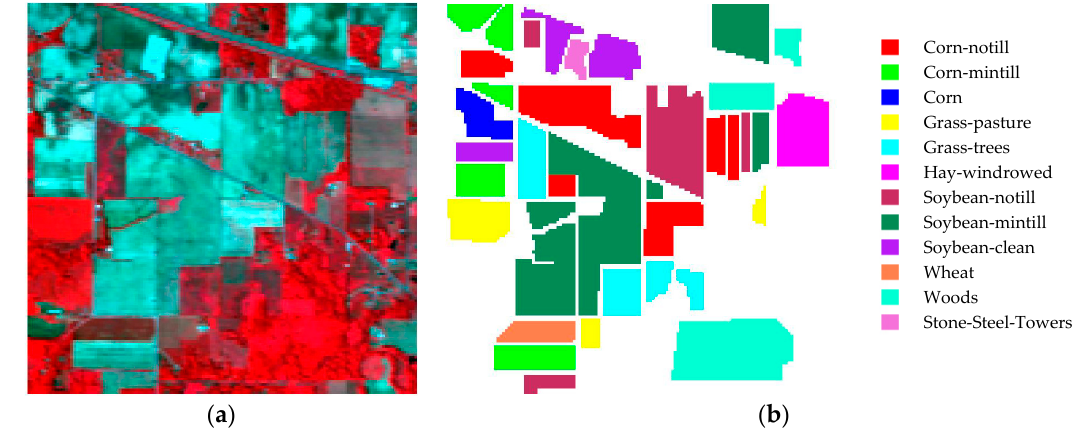
Figure 11. Indiana Indian Pines dataset: ( a ) False color composite of the AVIRIS image; ( b ) Ground truth map.